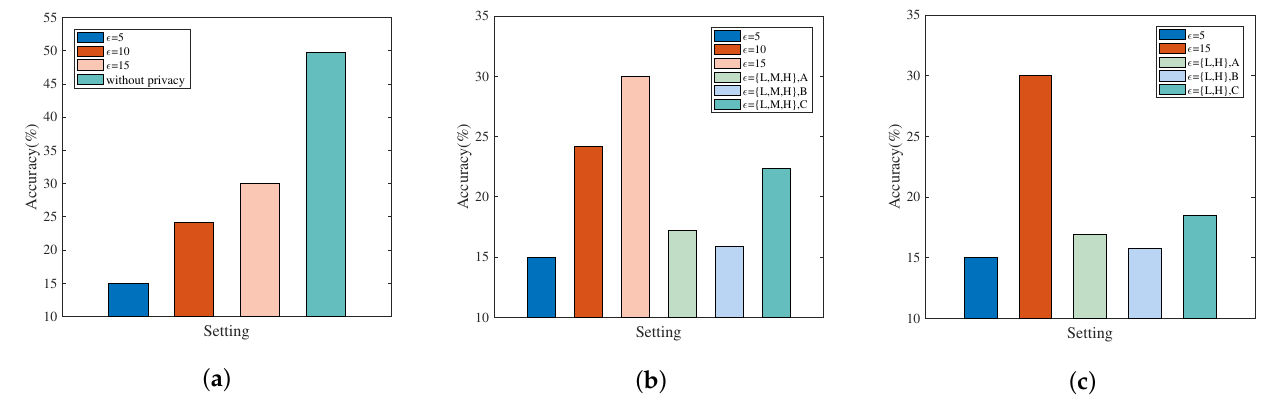
Figure 6. Simulation results on Fashion-MNIST data. Clients’ training data are non-independent and identically distributed. ( a ) The non-personalized scenario. ( b ) The personalized scenario under the first privacy setting. ( c ) The personalized scenario under the second privacy setting..